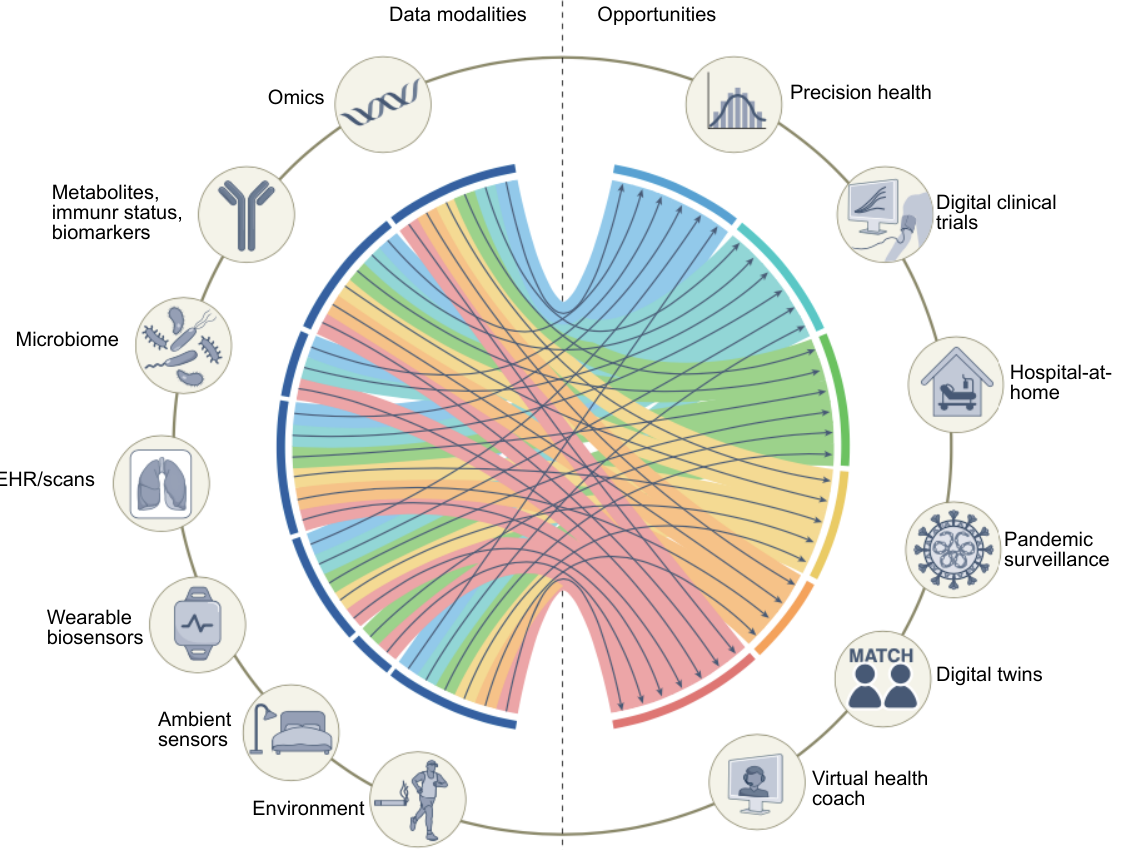
Figure 1 Multimodal data sources and opportunities applied in medica field. The large-scale multimodal models should be able to handle as many types of data that doctors can access in their clinical work as possible, even those that some doctors cannot access, such as some new disease data or some unpopular diseases. Unifying these data as the input of the large-scale multimodal model for processing, including data from medical sensors, genetic groups, proteomics, and so on. It can allow the AI model to fully consider multi-perspectives as much as possible, providing a multi-dimensional understanding of the disease, helping to make more accurate recommendations or decisions, and more effectively reduce doctors’ burden in daily clinical work